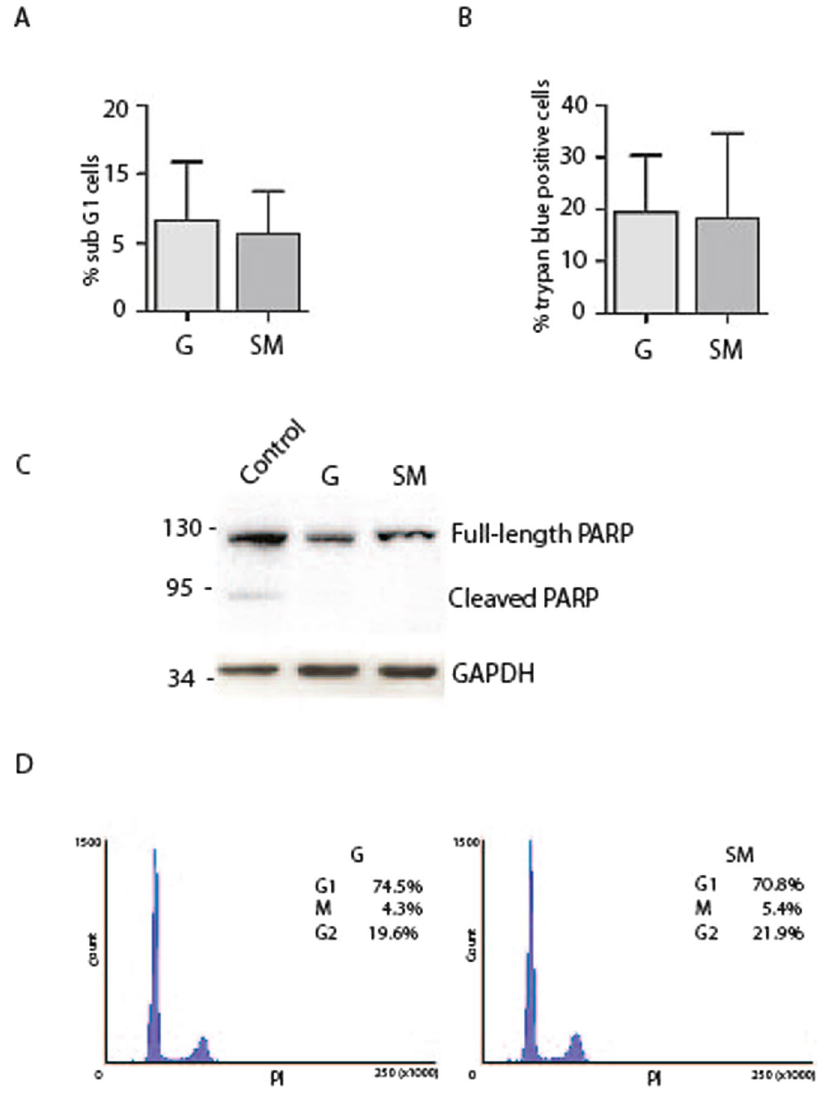
Figure 2. SM does not cause significative changes in Sertoli cell viability and cell cycle. ( A ) Percentage of sub G1 Sertoli cells cultured at G or under SM. Sertoli were cultured for 48 h and then analyzed by FACS after propidium iodide staining. ( B ) Percentage of Trypan blue positive Sertoli cells detected after 48 h of culture at G or under SM. ( C ) Analysis of cleaved-PARP in protein extracts from Sertoli cells cultured at G or under SM showing the absence of cleaved forms in SM and G conditions. In Control lane is reported a positive control in which embryonal carcinoma cells (2102EP cell line) were treated for 24 h with 3.3 µ M cisplatin. A cleaved band at around 89 kDa is shown. ( D ) Cell cycle analysis of Sertoli cells cultured for 48 h at G or under SM and then analyzed by FACS after propidium iodide staining. Most of the cells are in G1 phase in both culture conditions. At least three different experiments were performed. Bars represent